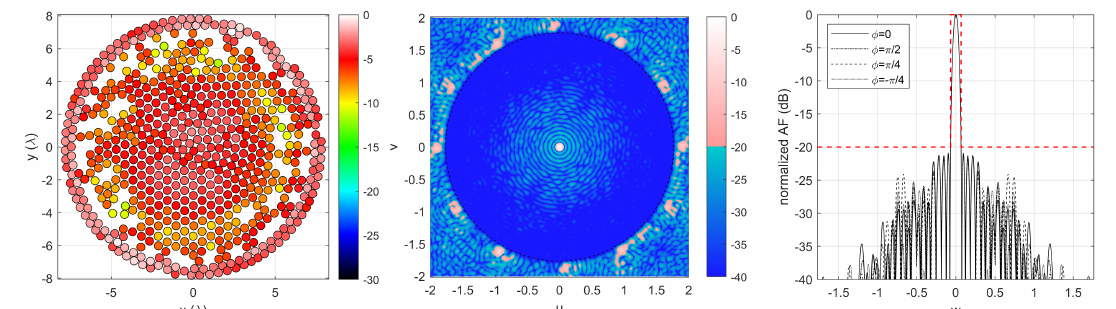
Figure 11. The 622 elements sparse layout. Left subplot: position and normalized excitation amplitude (dB) of the synthesized layout; center subplot: normalized Array Factor in the uv plane; right subplot: some relevant cuts. Negative values of w are related to the cuts φ (cid:48) = φ + π